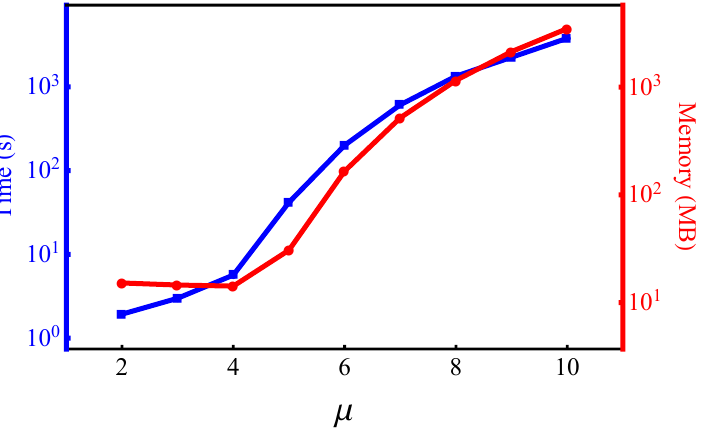
Figure 13 . Signals of the negative helicity component, ( k 12 k 34 /k 2 ferent chemical potential choices ( ˜ κ = 0 . 5 , 0 , − 0 . 5 ), with the mass fixed to be µ = 3 . Each plot is normalized by their maximum. We see that oscillations in different directions dominates different parameter ranges. Without chemical potential, two CC signals share the same magnitude. As the chemical potential is turned on, the non-local type becomes dominant (subdominant) if the chemi- cal potential is positive (negative).